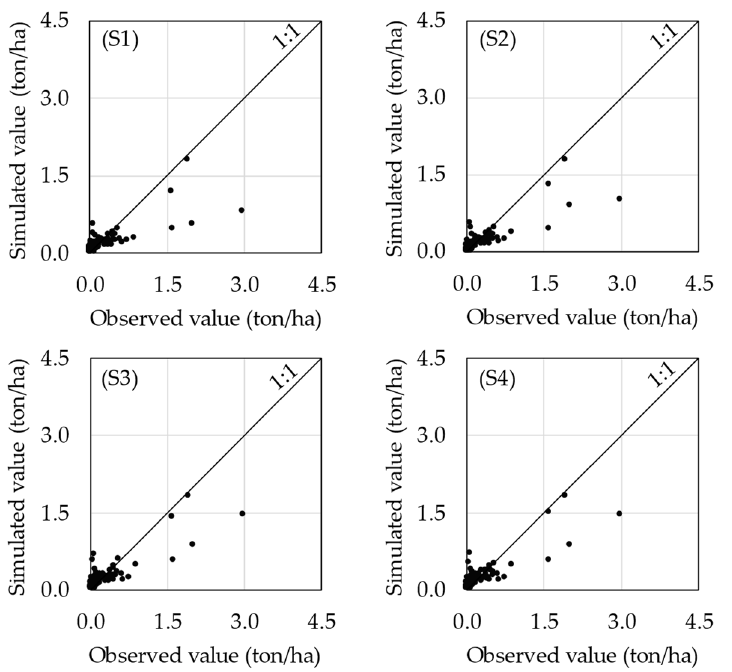
Figure 6. The correlation between the observed and simulated sediment discharges in the validation period. S1 represents the simulation results when using the 2005 land- use map for the entire validation period. S2 represents the simulation results when using the 2010 land- use condition for the entire validation period. S3 represents the simulation results when using two land- use condition types for 2010 and 2015 and then linearly interpolating toward 2015 after 2010, where the 2015 land- use condition is then employed during the 2015–2018 simulation. S4 represents the simulation results when using three land- use condition types during the validation period and then linearly interpolating between two land- use conditions.